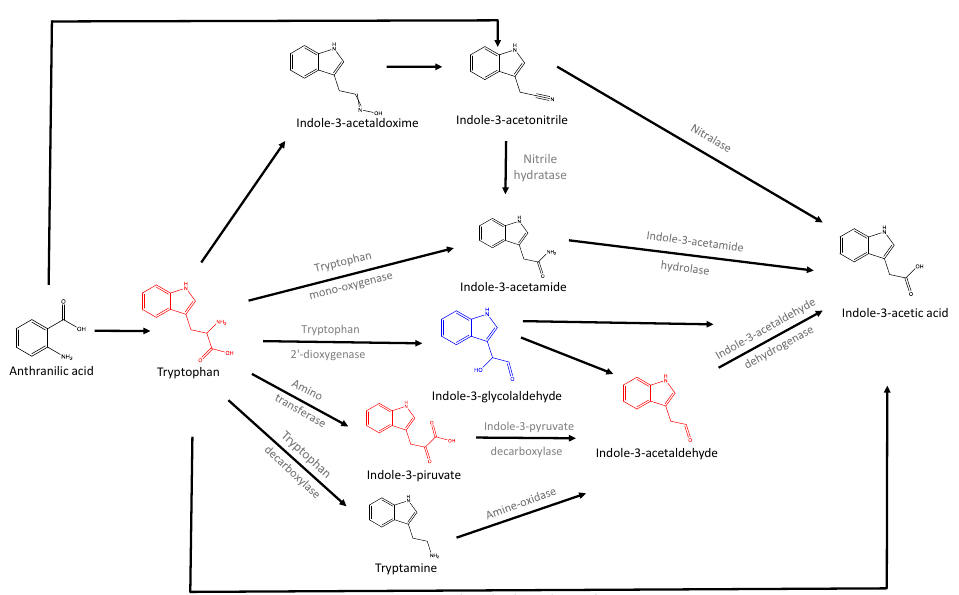
Figure 3. Overview of microbial production pathways of indole-3-acetate. Black molecules: metab- olites unidentified; red molecules: metabolites identified and confirmed by MS/MS spectra fragmen- tation; blue molecule: metabolite proposed as new parallel pathway. Adapted from Spaepen et al., 2011 [35] and modified.